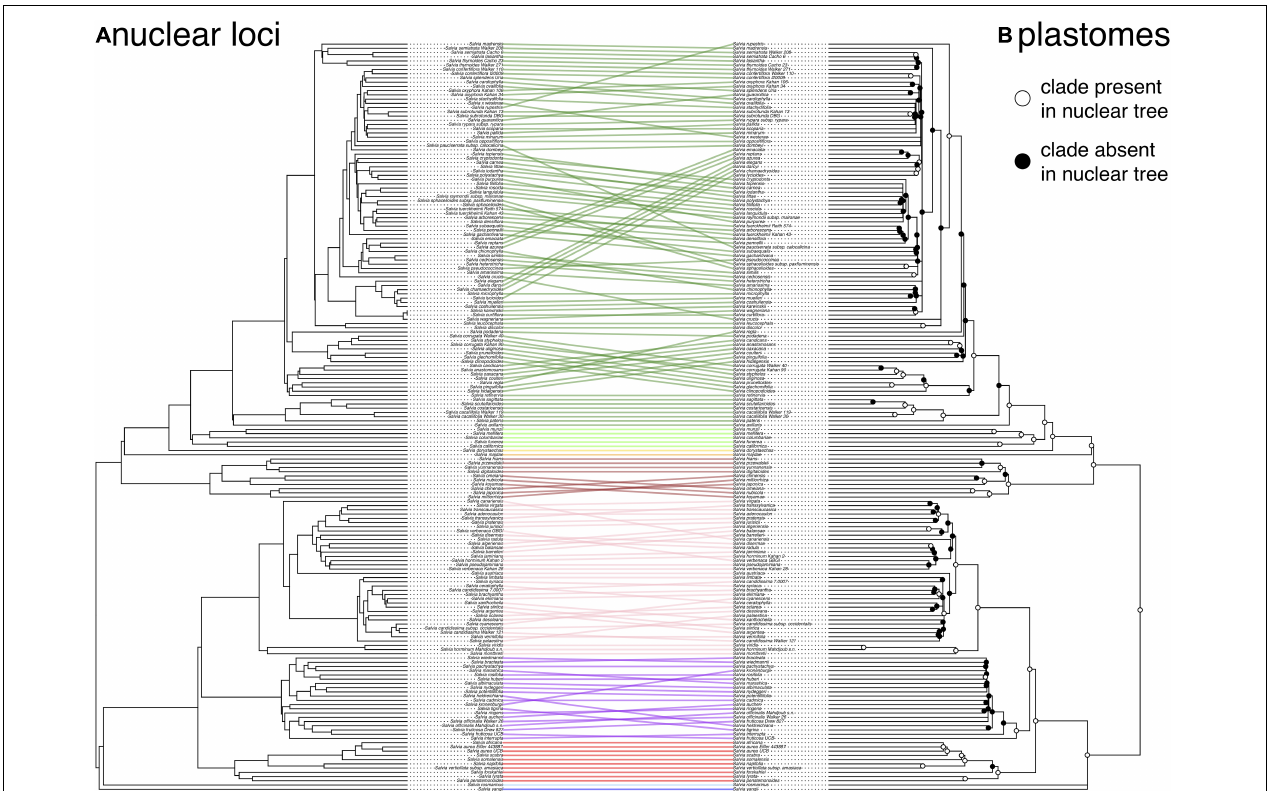
FIGURE 2 | Tanglegram illustrating the cytonuclear discordance in Salvia based on the nuclear ASTRAL species tree (A) and the plastome tree (B) . Links connect identical tips, with nodes rotated to minimize the link overlap. Ingroup links are colored by subgenus. Clades that differ between the two trees are indicated by filled circles on the plastome tree. To minimize the discordance caused by the error in the gene tree estimation, clades in the plastome tree with < 75% bootstrap support have been collapsed into polytomies.